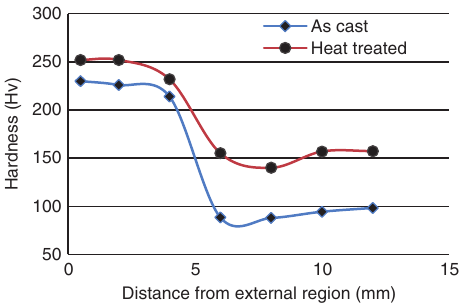
Figure 7 Variation in hardness from the external region of the as-cast and heat-treated SiC/Al-Cu-Mg FG